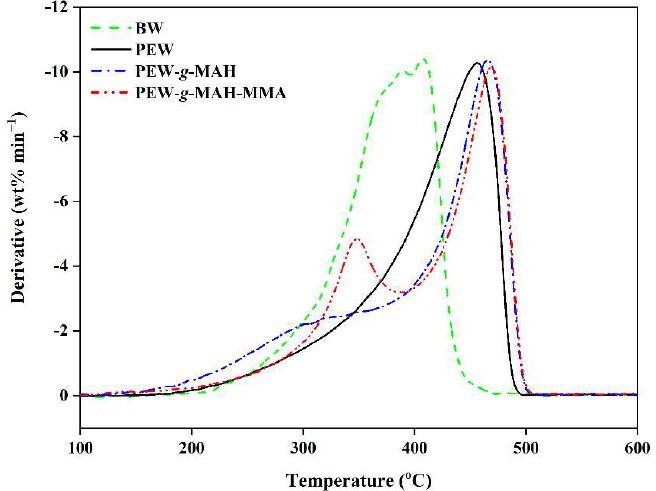
Figure 6. The derivative mass loss (DTG) curves of BW, PEW, PEW- g -MAH, and PEW- g -MAH-